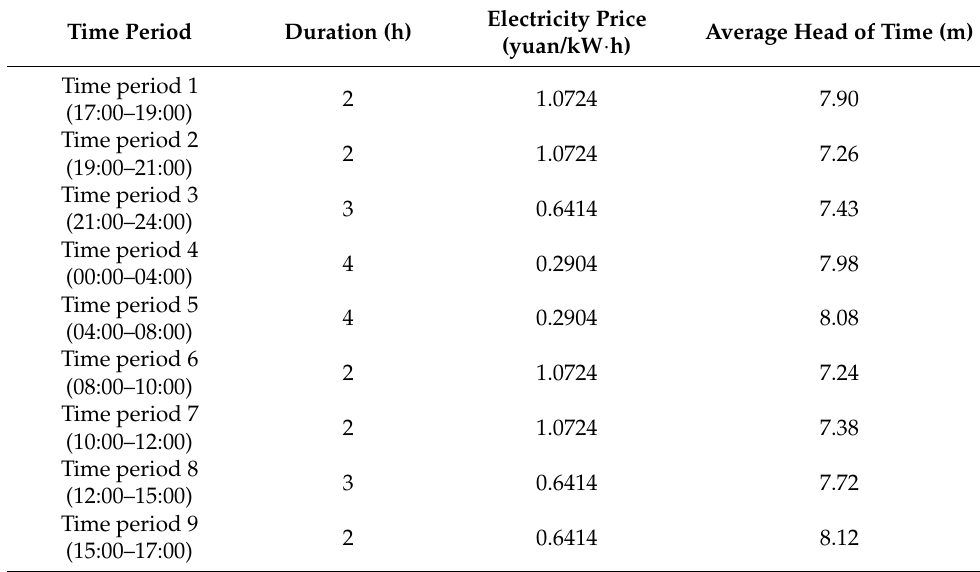
Figure 3. Combined schematic diagram of peak–valley electricity price and time-averaged head of the Jiangdu parallel pumping station group under an average daily head of 7.8 m. Table 2. Electricity price of each time period and corresponding hourly average lift when the average daily lift is 7.8 m.